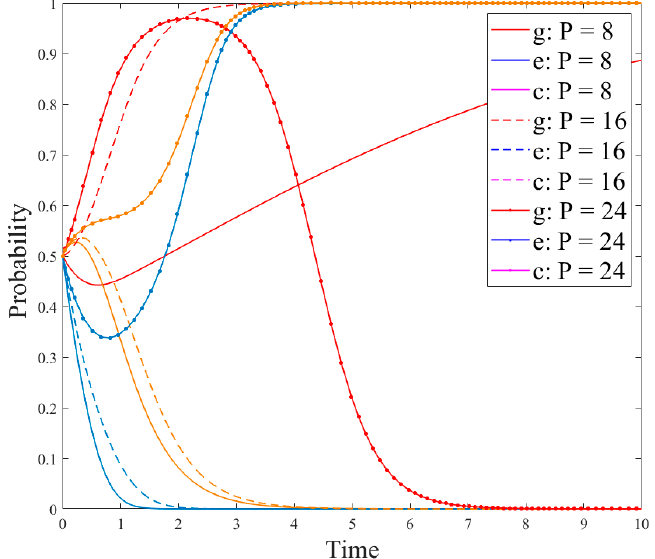
Figure 10. Evolution results of system strategy with different penalty(P) ( g : government, e : enterprise, c : consumer) ( P : penalty imposed by the government on enterprises that have cheated or produced substandard products).